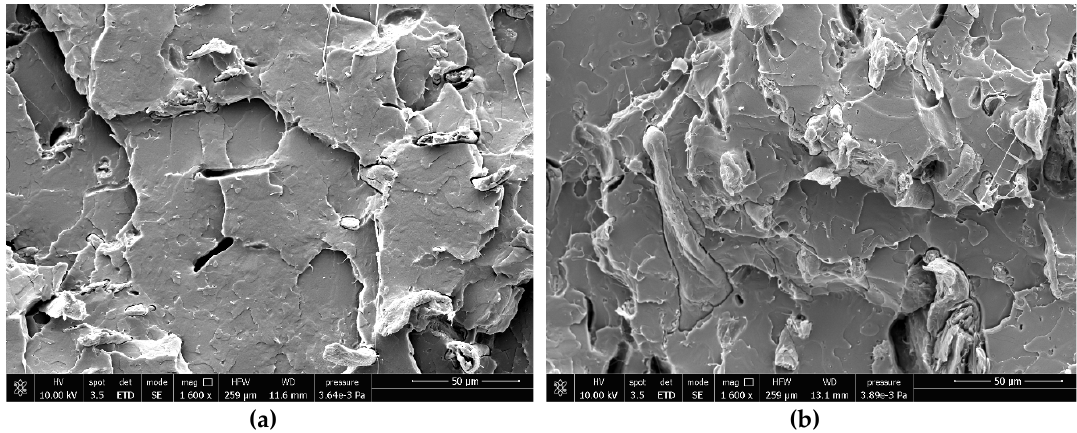
Figure 4. SEM micrographs of composites: ( a ) PLA + 10 wt % Be600/PU, ( b ) PLA + 10 wt % BWW40.